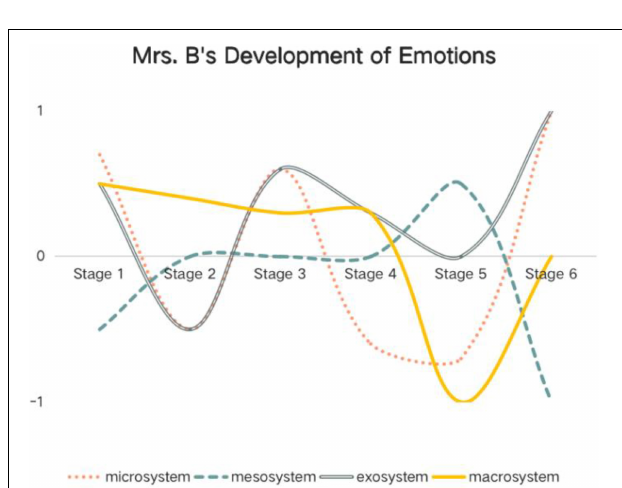
FIGURE 3 | Mrs. B’s development of emotions within different ecological system.